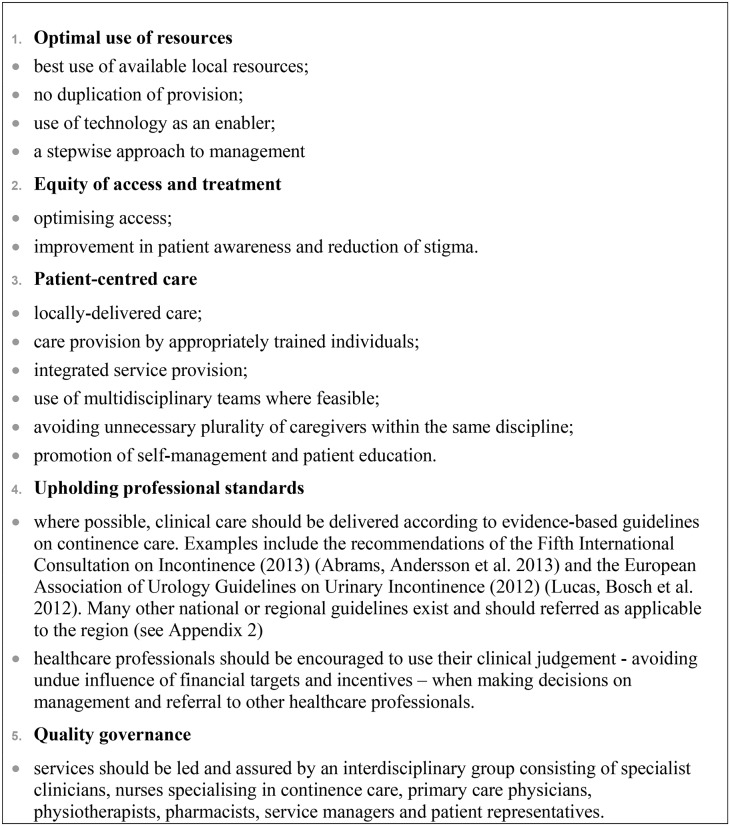
Patient profiles.